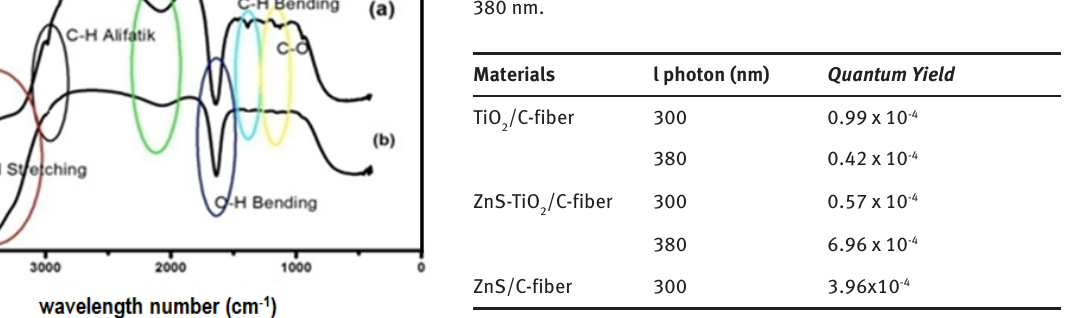
Table 2: The QY values of each material as calculated by equation (1) from isopropanol degradation data at photon radiation of 300 and 380